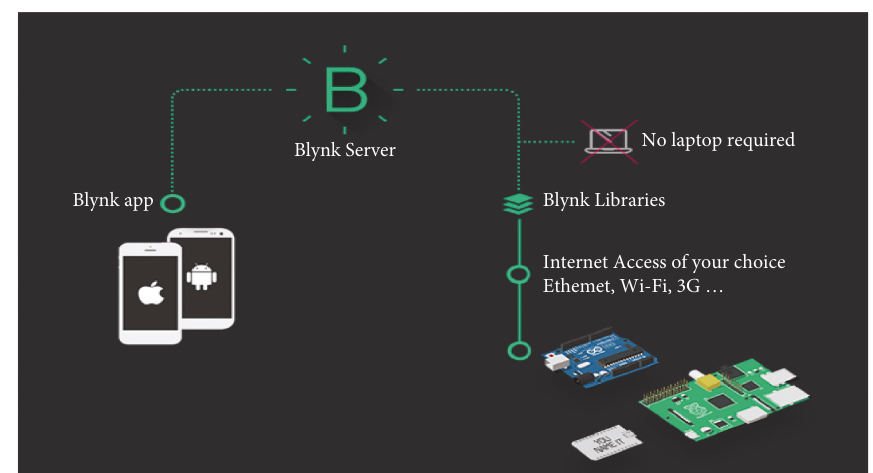
Figure 5: Front panel of Blynk